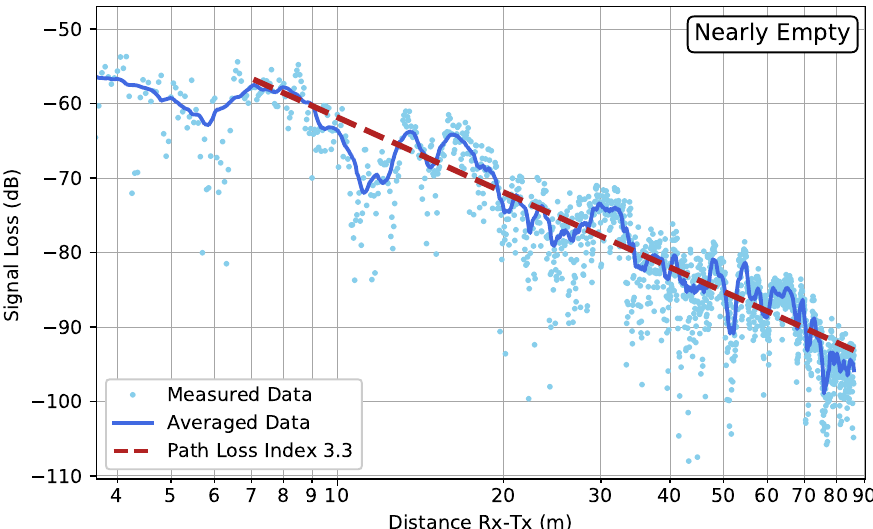
Figure 9. Scenario FW (HR): The high-resolution measured data in the case of a nearly empty parking garage. The average computed by Equation (3) is shown by the solid line, whereas the fitted path loss line is indicated by the dashed line.